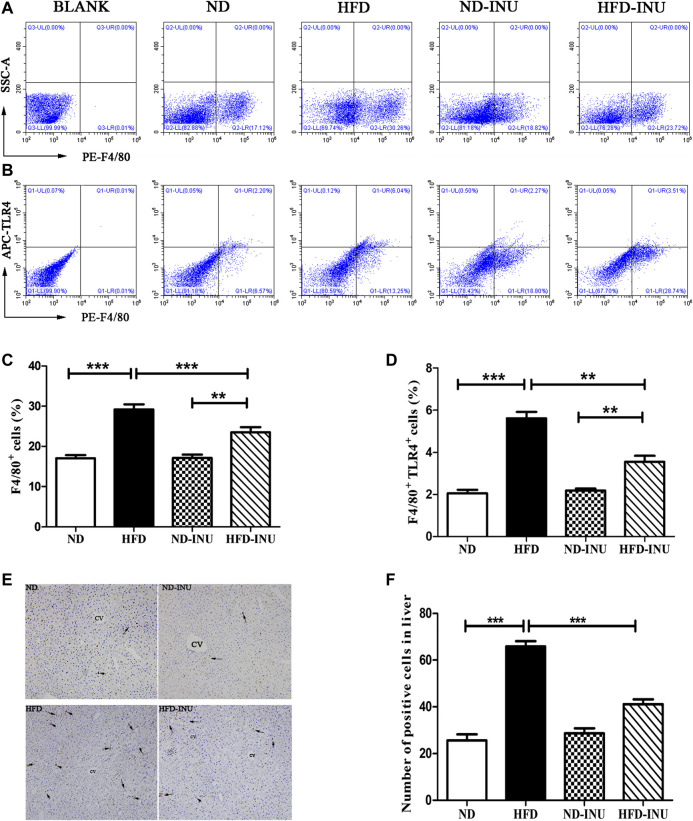
Effects of INU treatment on hepatic Mψs and TLR4 expression of Mψs in NAFLD by flow cytometry and immunohistochemistry. (A) Flow cytometry analysis of liver F4/80 + cells in diverse groups (B) Flow cytometry analysis of liver F4/80+TLR4+ cells in diverse groups (C) The proportion of liver F4/80 + cells (D) The proportion of liver F4/80 + TLR4+ cells (E) Results of hepatic immunohistochemistry were stained by F4/80 antibody (F) The number of positive Mψs in diverse groups. Hepatic Mψs were stained as brown and shown with arrows in the figure (E). CV: central vein. Original magnification, ×200. Data are expressed as mean ± SEM; *p < 0.05, **p < 0.01, ***p < 0.001. All experiments were performed in triplicate. Mψ: macrophage; TLR4: Toll-like receptor four; INU: inulin; ND: normal diet; HFD: high-fat diet.